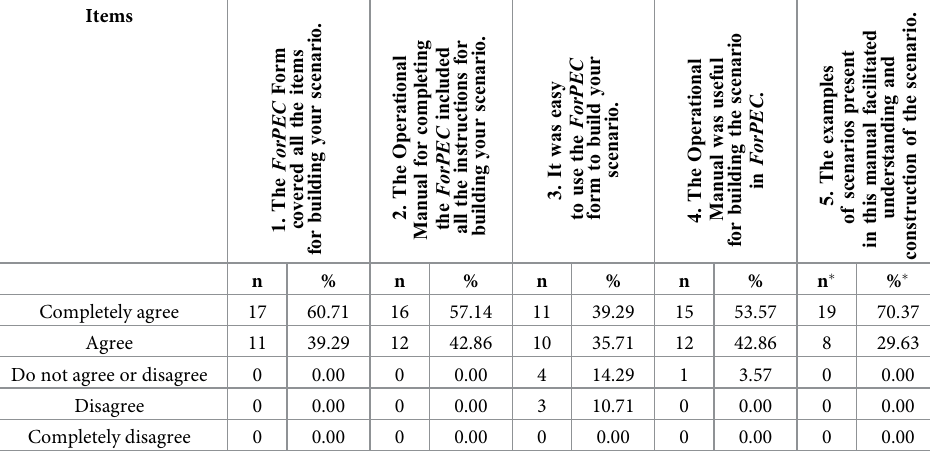
Table 6. Feasibility assessment of the ForPEC and its Operational Manual by participants after scenario develop- ment (n = 28). Sao Paulo, SP, Brazil, 2018.